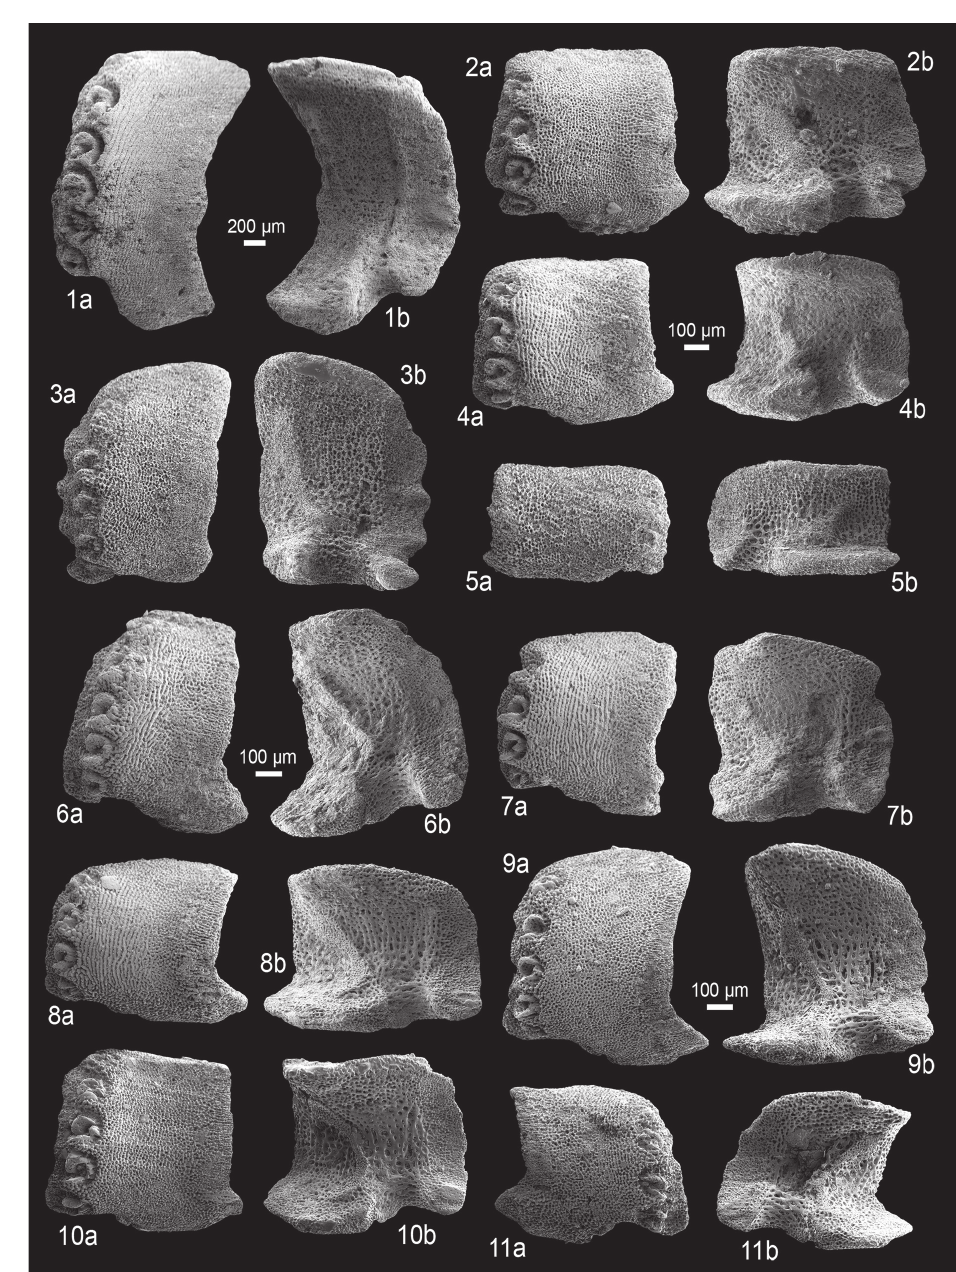
Fig. 29. Fossil lateral arm plates (LAPs) of ophiacanthid brittle stars in external (a) and internal (b) views. 1. Dermocoma sp. nov. innom. 4 from the early Albian (Early Cretaceous) of Leighton Buzzard, Great Britain; NHM EE 14844, proximal LAP. 2-5. Dermacantha pattyana gen. et sp. nov. from the Hettangian (Early Jurassic) of Fontenoille, Belgium. 2. MnhnL HE414 (holotype), proximal LAP. 3. MnhnL HE415 (paratype), proximal LAP. 4. MnhnL HE416 (paratype), median LAP. 5. MnhnL HE417 (paratype), distal LAP. 6-8. Dermacantha seeweni (Kutscher & Hary, 1991) comb. nov. from the late Sinemurian (Early Jurassic) of Bishop’s Cleeve, Great Britain. 6. GZG.INV.78706, proximal LAP. 7. GZG.INV.78707, median LAP. 8. GZG.INV.78708, distal LAP. 9-11. Dermacantha leonorae gen. et sp. nov. from the early Pliensbachian (Early Jurassic) of Blockley, Great Britain. 9. GZG.INV.78710 (holotype), proximal LAP. 10. GZG.INV.78711 (paratype), median LAP. 11. GZG.INV.78712 (paratype), distal LAP. One common scale bar per